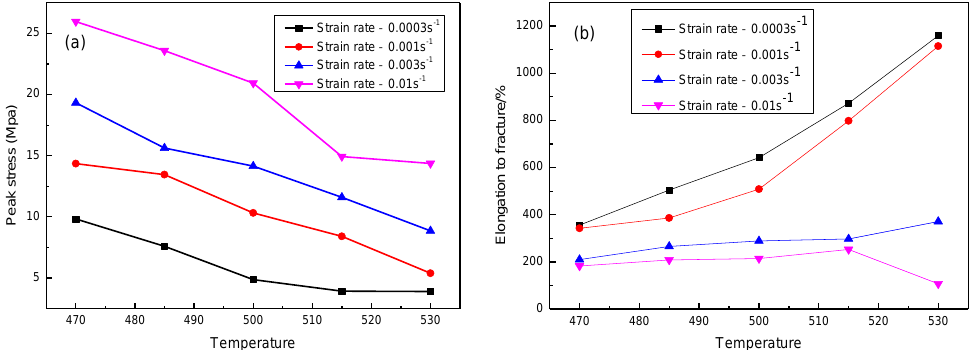
Figure 2. ( a ) The effect of deformation parameters on the peak stress and ( b ) the effect of deformation parameters on the elongation.